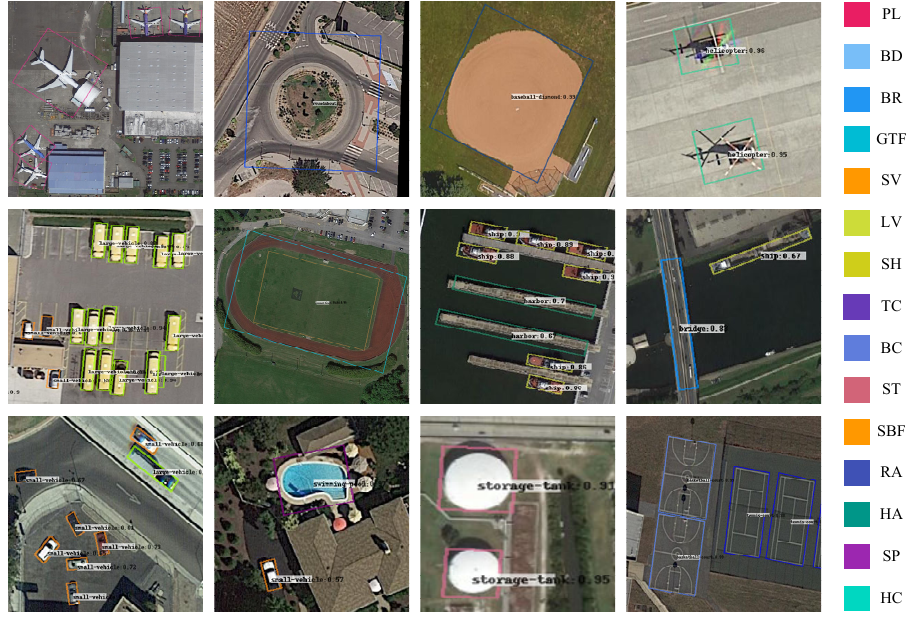
Figure 9. Visualization of some detection results on DOTA. Different colored bounding boxes represent instances of different categories (best viewed in